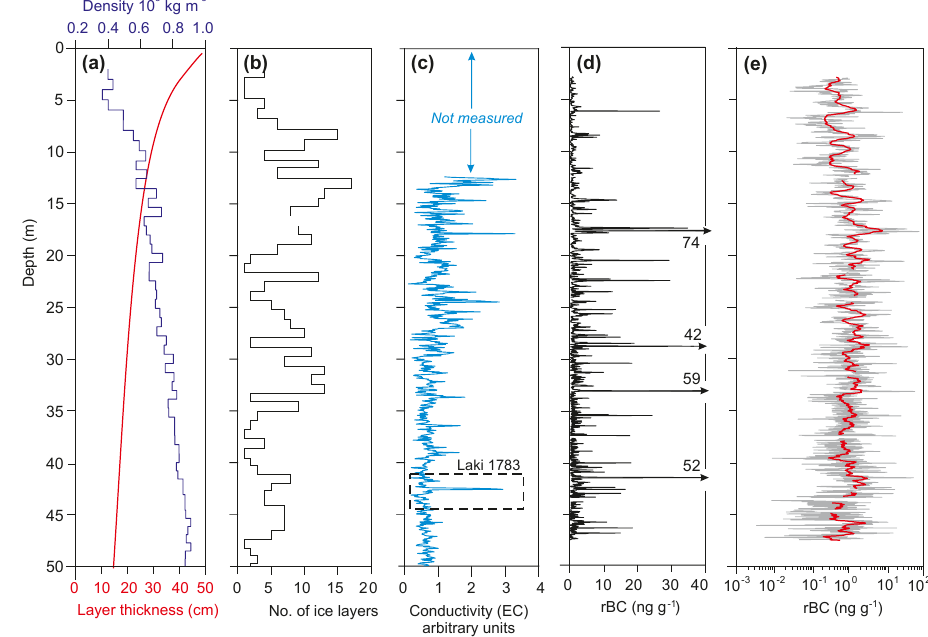
Figure 3. Profiles of physical properties and rBC in the top 48–50m of the DV99.1 ice core. (a) Firn density and estimated mean annual layer thickness. (b) Frequency of discrete ice layers ( > 3mm thick) per core section. (c) Solid-state electrical conductivity (EC) profile of the core from 12.8 to 50m depth, smoothed to a vertical resolution of ∼ 1cm. The EC peak attributed to acidic fallout from the Laki 1783 eruption is labeled. (d, e) rBC concentrations plotted on linear and log scales. The bold red line is a 50-point ( ∼ 1m) moving